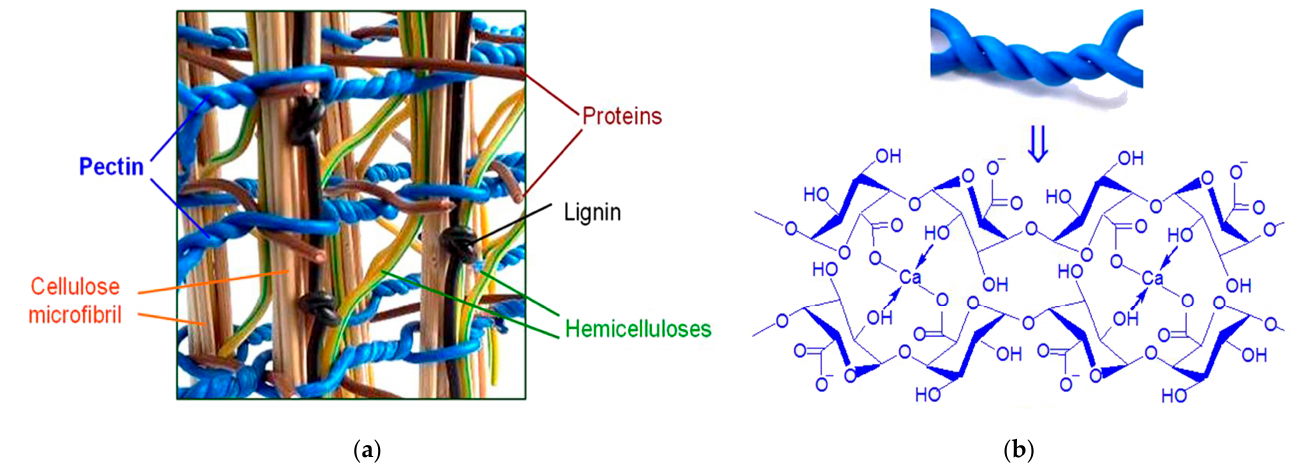
Figure 1. Schemes ( a ): Carbohydrate–protein complex structure in the plant cell wall and ( b ): Interchain crosslinking of pectin macromolecules by “egg-box” complexes.